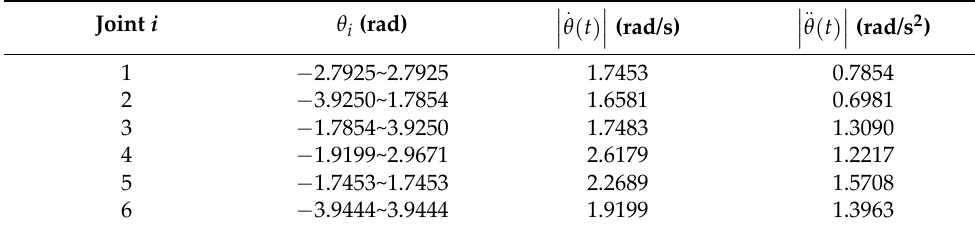
Table 4. Maximum constraints of joint angular position, angular velocity, and angular